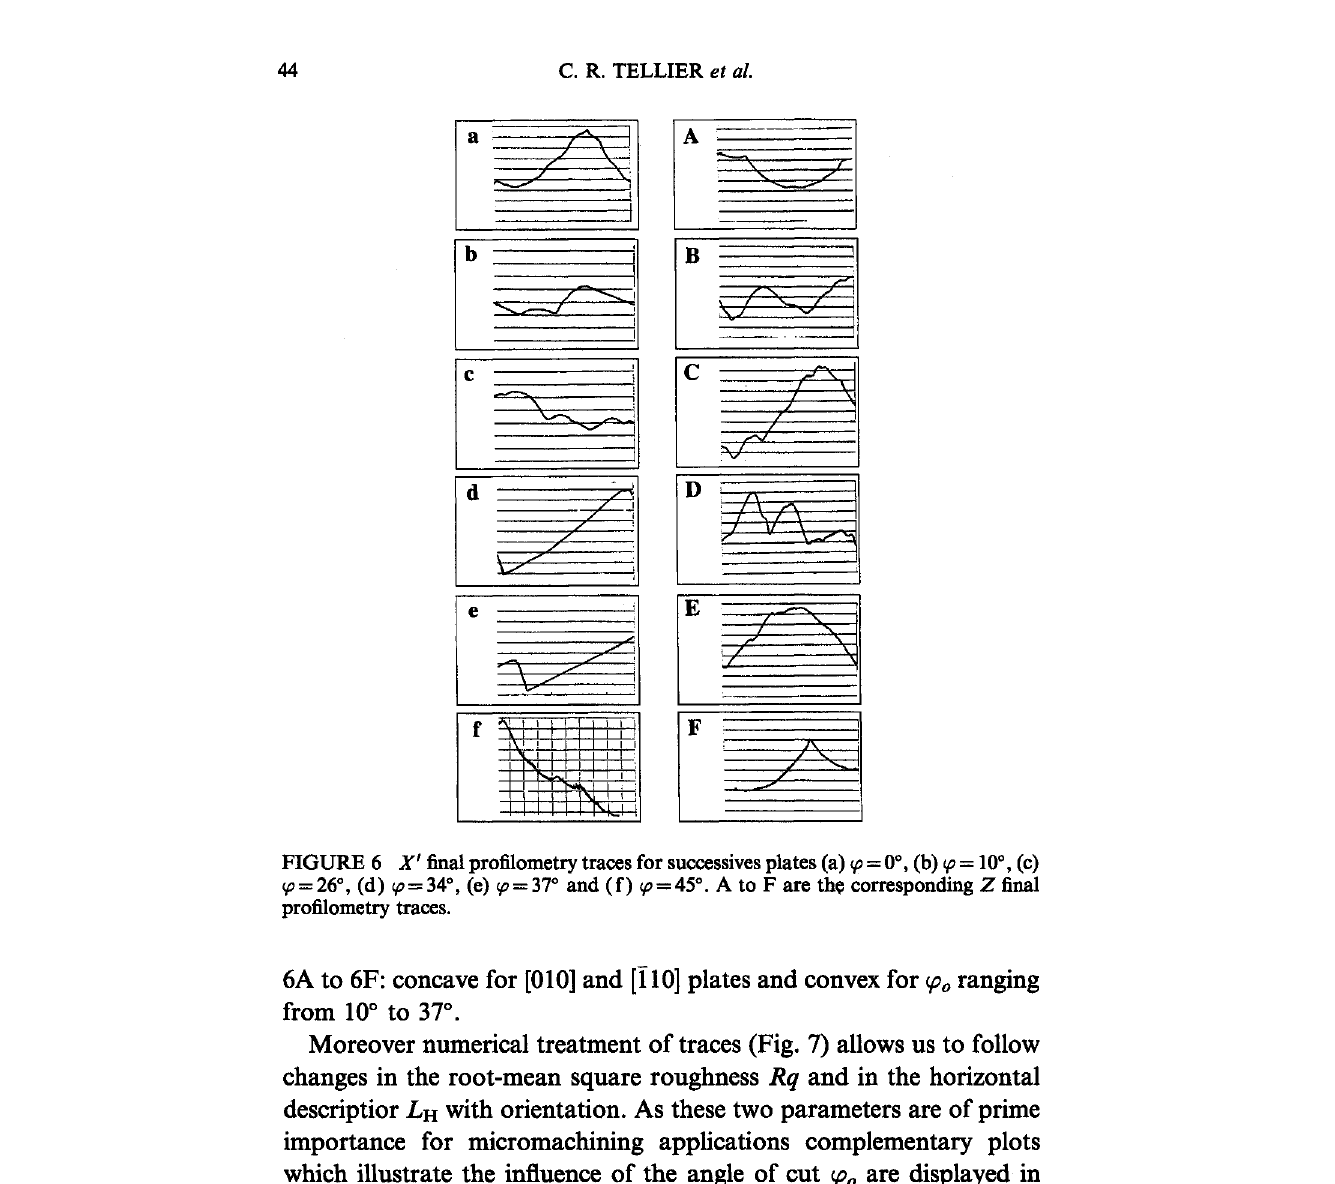
, , FIGURE 6 X final profilometry traces for successives plates (a) =0 = (e) 37 and (f) 45 (d) 26 34 profilometry traces. 6A to 6F: concave for [010] and [110] plates and convex for o ranging from 10 to 37